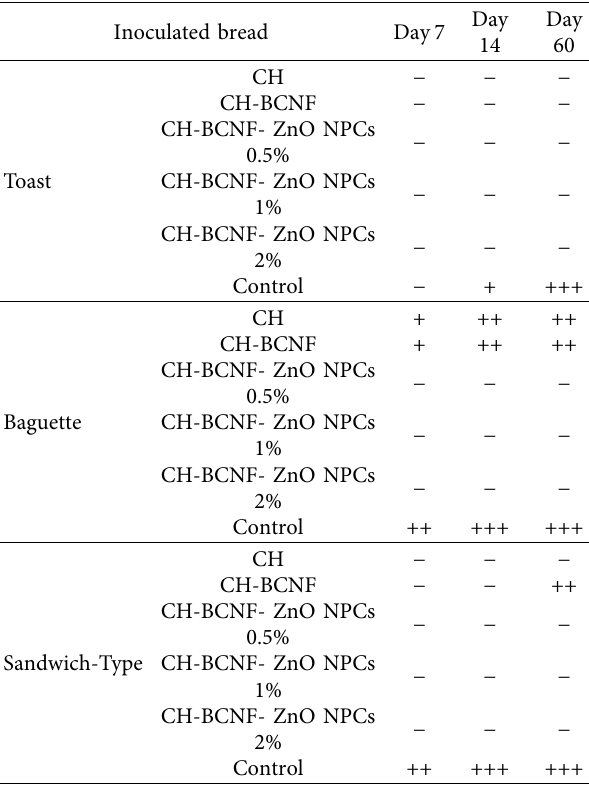
Table 6: Visual observation of mold growth in noninoculated bread at 25 ° C.